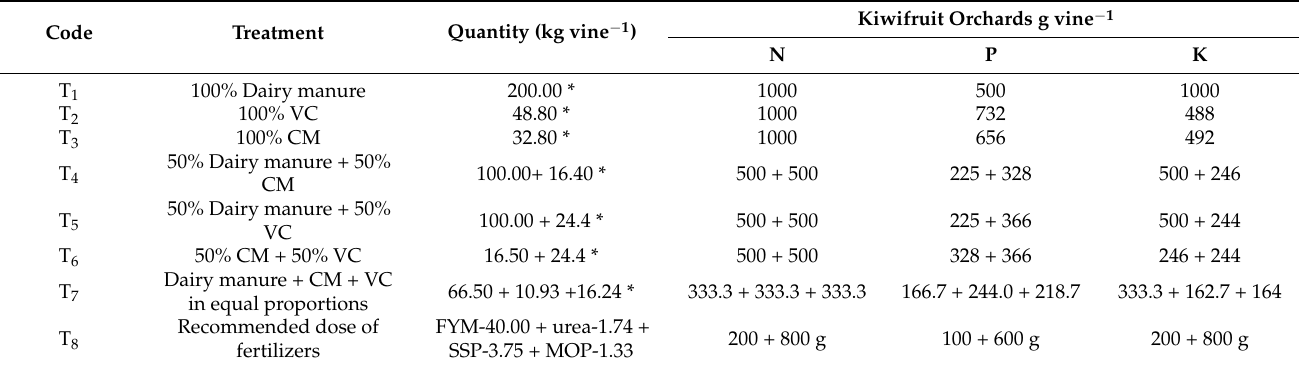
Table 5. Nutrient application rates for Kiwifruit orchards during the